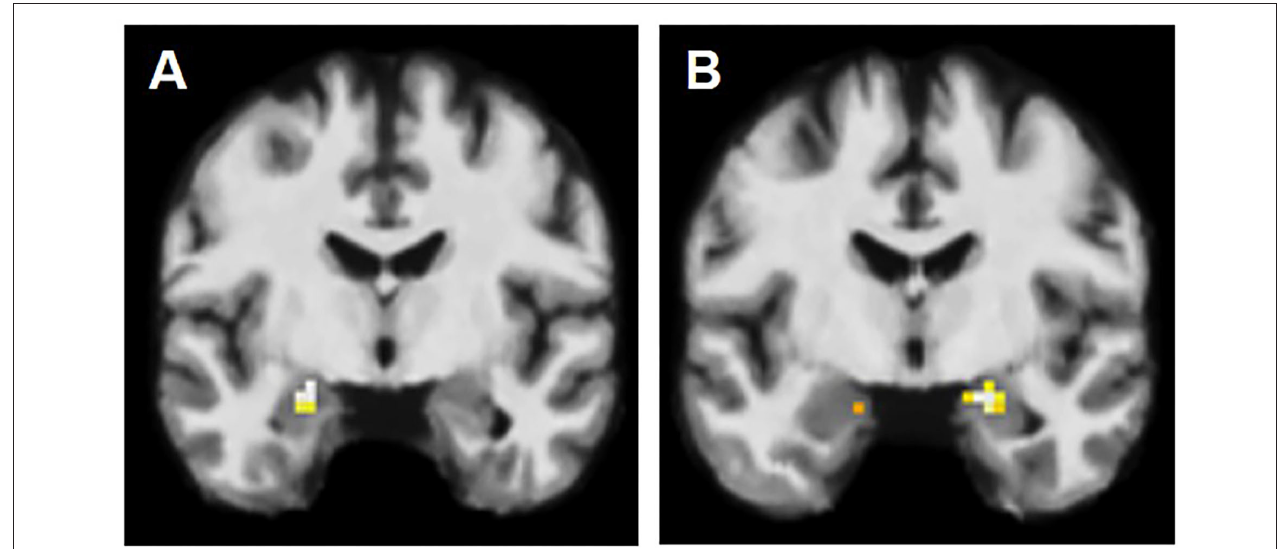
FIGURE 1 | fMRI activation patterns in amygdala lesions. (A) BOLD signal in left amygdala, contralateral to the AE on the right. (B) BOLD signal in amygdala bilaterally, however more on the right than on the left (left-sided AE).